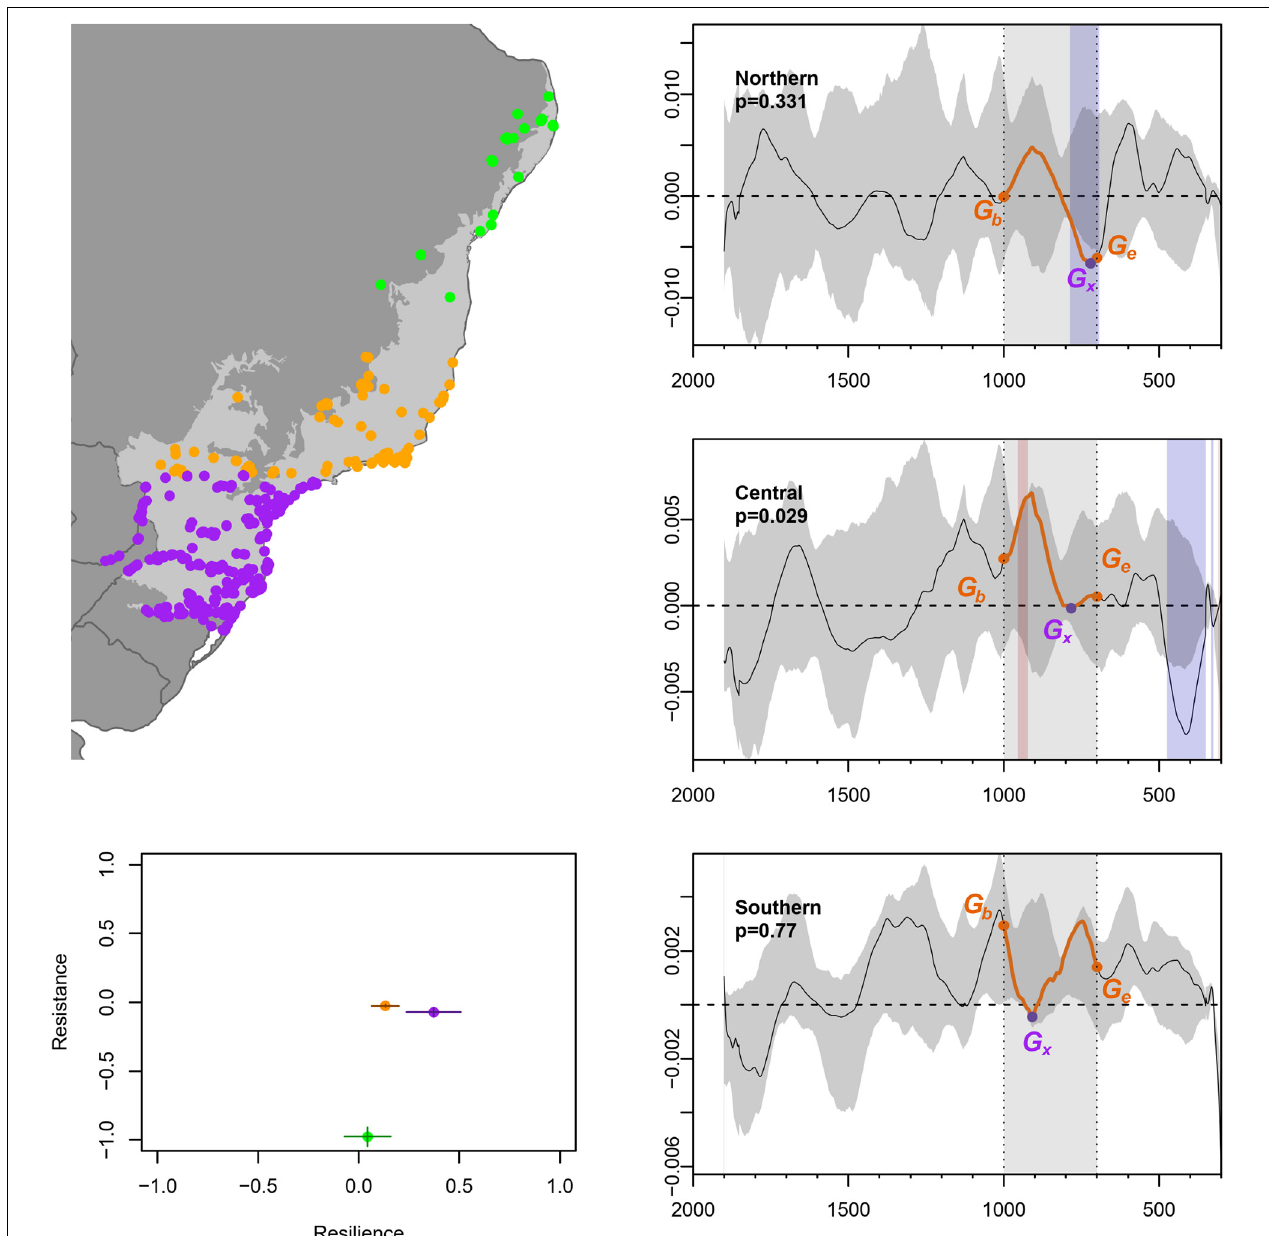
FIGURE 5 | Results of point-to-point permutation test for resistance-resilience. Right column: Rate of change of SPDs in Northern, Central, and Southern subsets of the Atlantic Forest, with p-values for the underlying permutation test. Simulation envelope is based on 1,000 random mark permutations. Orange dots and shading show the defined start- and end-points of the MCA, purple dots are the minima of the time series between these points. Note that with a 100-year backsight, the time series starts at 1,900 cal BP. Bottom left: comparisons of resistance-resilience between regions. TABLE 3 | Resilience-resistance metrics and significance test for Northern, Central, and Southern subsets of Atlantic Forest radiocarbon record, and time in years between start of disturbance and time series minima (lag). Region Resistance p -value Sig. Resilience p -value Sig. Lag (years) Northern − 0 . 9758 0 . 002 *** 0 . 0442 0 . 2312 ns 280 Central − 0 . 0265 0 . 002 *** 0 . 1328 0 . 6166 ns 217 Southern − 0 . 0708 0 . 002 *** 0 . 3736 0 . 9964 ns 91 All resistance values are highly significant (*** ≤